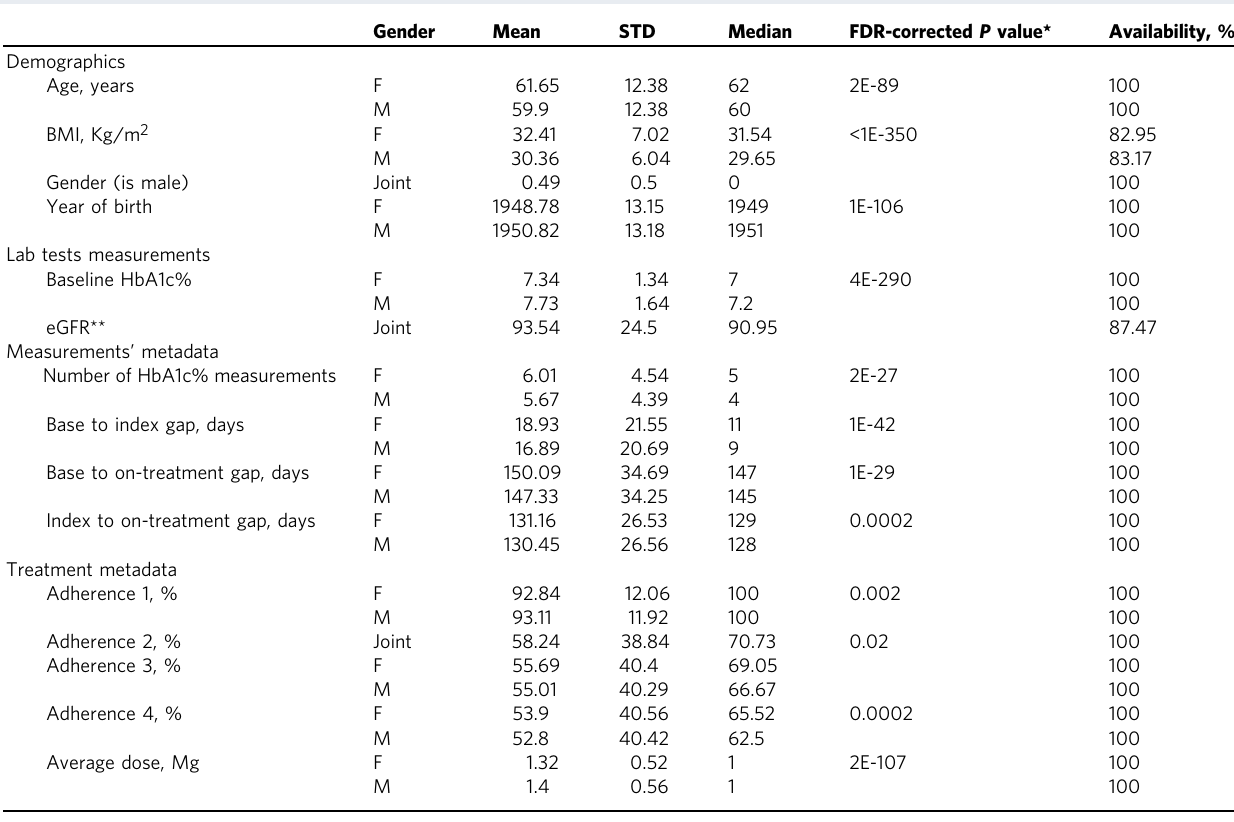
Fig. 1 T2D patients ’ selection. Patients were determined by ful fi lling at least one of three criteria: (1) HbA1c% lab test value>6.5%; (2) plasma glucose lab test value>200 mg/dL; (3) T2D diagnosis. Green applies to lab test results, red to diagnoses, and yellow to patients. In total, 782,159 T2D patients were identi fi ed. Table 2 Baseline characteristics of the study